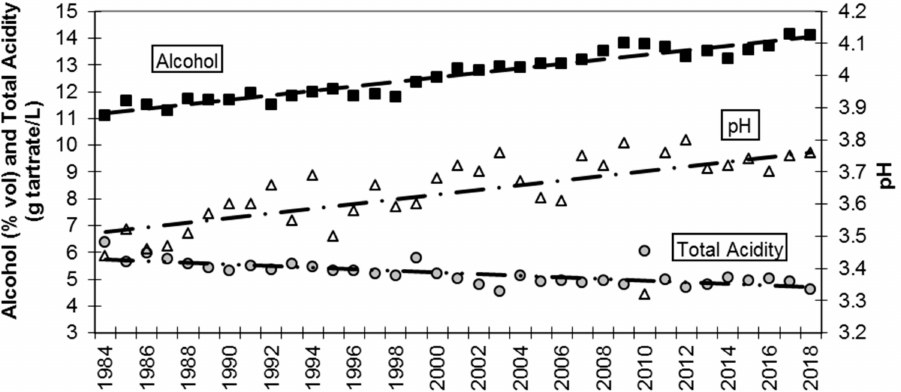
Figure 5. Evolution of red wine composition in the Languedoc region (France) from 1984 to 2018. Each data point is the average of several thousands of analyses of red wines just after alcoholic fermentation (data: Dubernet laboratory, F-11100 Montredon des Corbi è